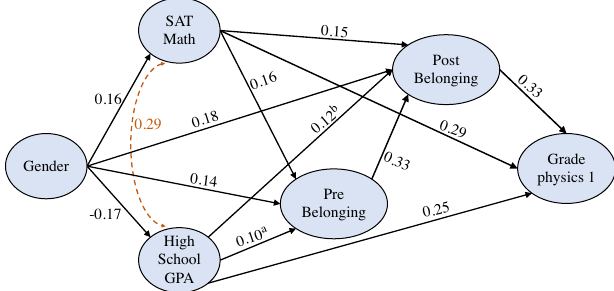
FIG. 2. Result of the path analysis part of the SEM between gender and physics 1 grade through students ’ sense of belonging. The line thickness indicates the relative magnitude of β values. The dashed line indicates covariances between constructs. The gender variable was coded as 1 for men and 0 for women, so paths from gender with β > 0 indicate a higher mean for men while β < 0 indicate a higher mean for women in the predicted variable. All p values are indicated by no superscript for p < 0 . 001 , superscript “ a ” for p ¼ 0 . 014 , and superscript “ b ” for p ¼ 0 . 001 . Gender does not directly predict the physics